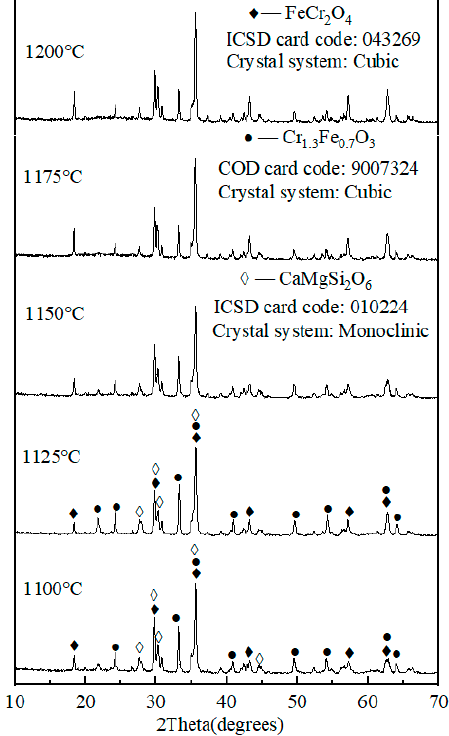
Figure 7. XRD patterns of ceramic tiles with Fe/Cr =2.0 sintered at different temperatures for 30 min.